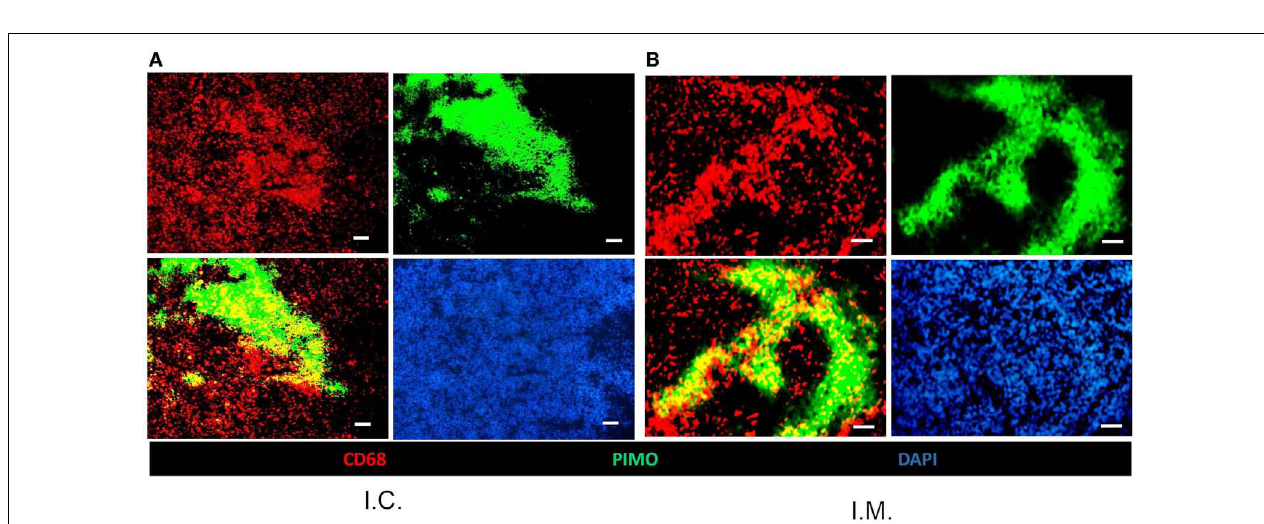
(A) and GL261 glioma (B) grown in the brain. Green: anti-PIMO stain for hypoxic region; red: anti-CD68 antibody forTAMs. Merged images: the colocalization of hypoxia andTAMs. Scale bar = 100 µ m.